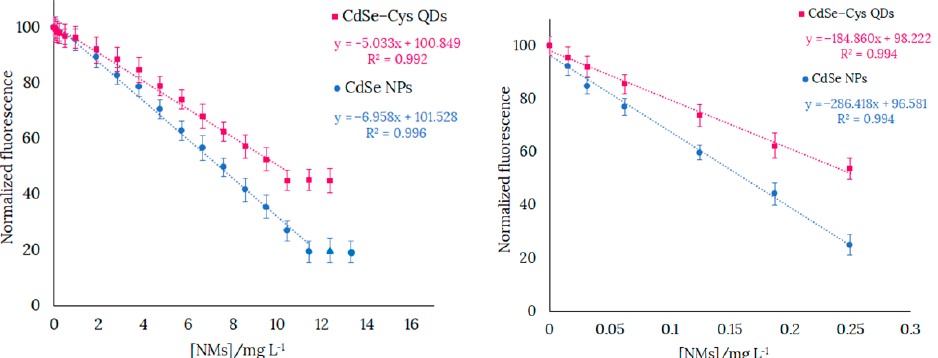
Figure 2. C alibration curve of fluorescence intensity of H 3 L in 80:20 ethanol/water solution at pH 11 with gradual addition of NMs (until the fluorescence intensity stops decreasing). Left : [H 3 L] = 126 ppb. Right : [H 3 L] = 1.26 ppb. NaOH 0.1 M was used to deprotonate H 3 L. Final volume of the solu-